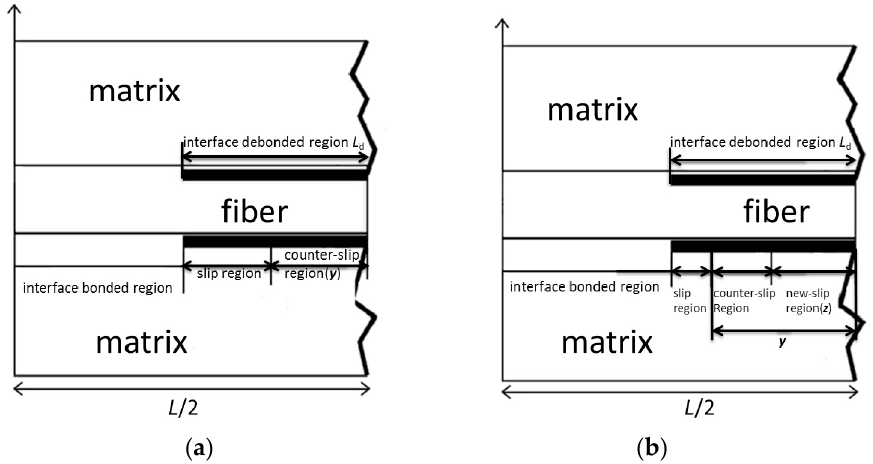
Figure 2. The schematic figure for fiber slipping relative to matrix upon: ( a ) unloading; and ( b ) reloading [18].